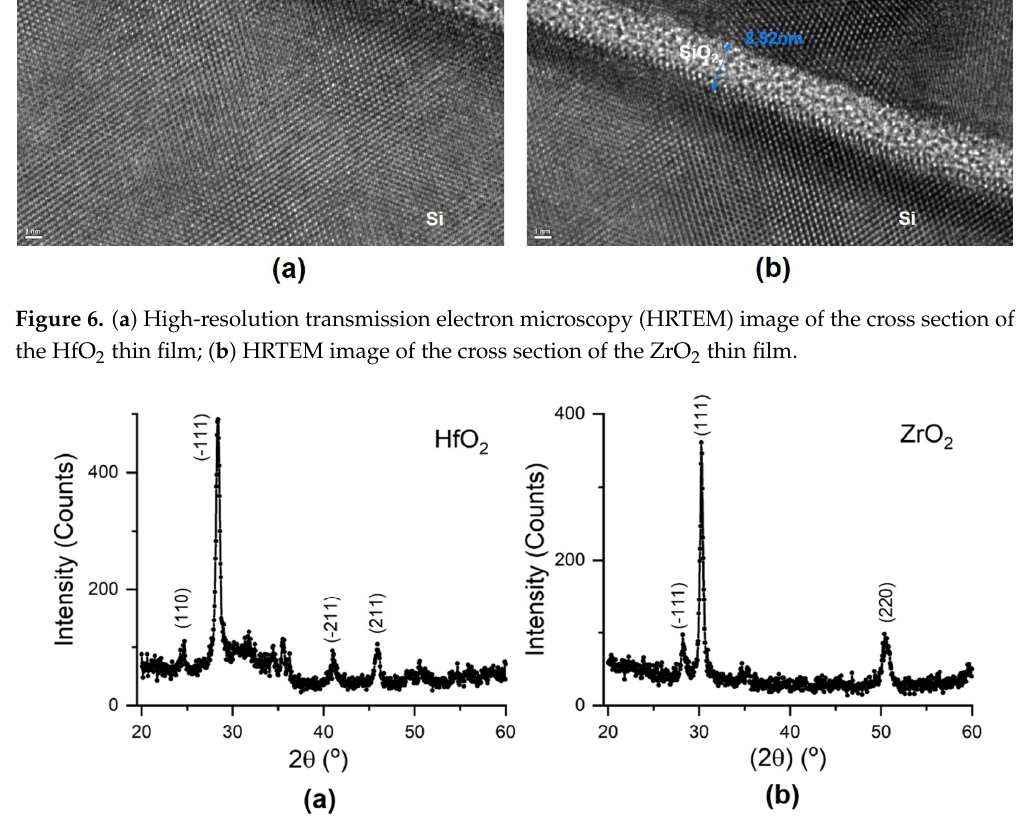
Figure 9. SEM image of a complementary metal-oxide semiconductor (CMOS) ring oscillator fabricated with HfO 2 or ZrO 2 as the gate oxide.